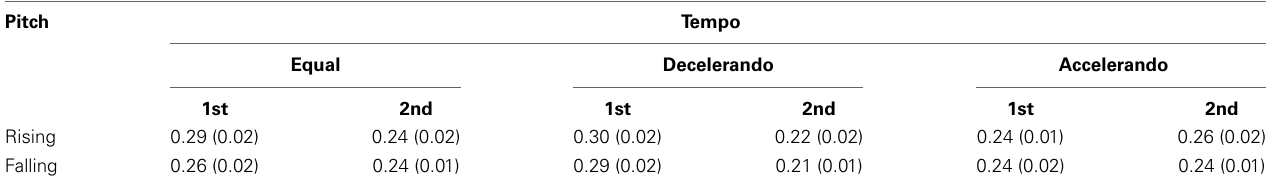
Table 3 | Mean speed of hand movement for the interaction quarter × pitch × tempo (second half of stimuli).